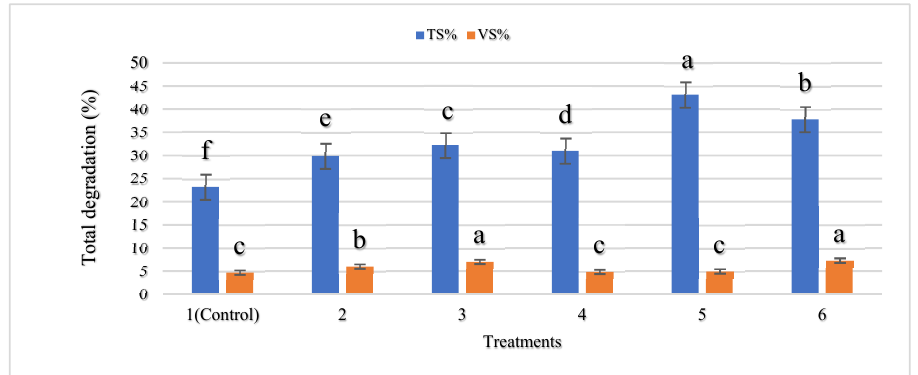
Figure 12. Degradation of total solids (TS) and volatile solids (VS) during anaerobic digestion. Bars with different letters depict significantly different values at p ≤ 0.05.